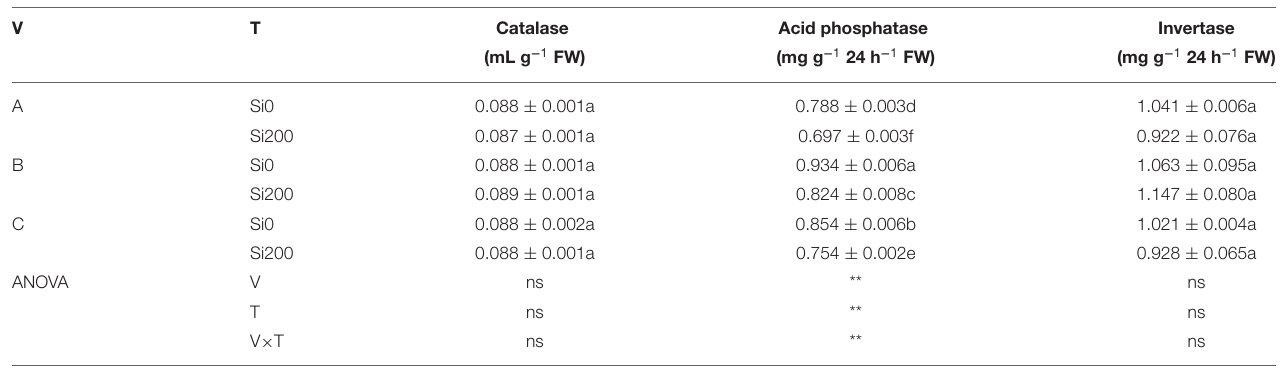
TABLE 2 | Soil enzyme activities of the three sugarcane varieties under the two silicon (Si)